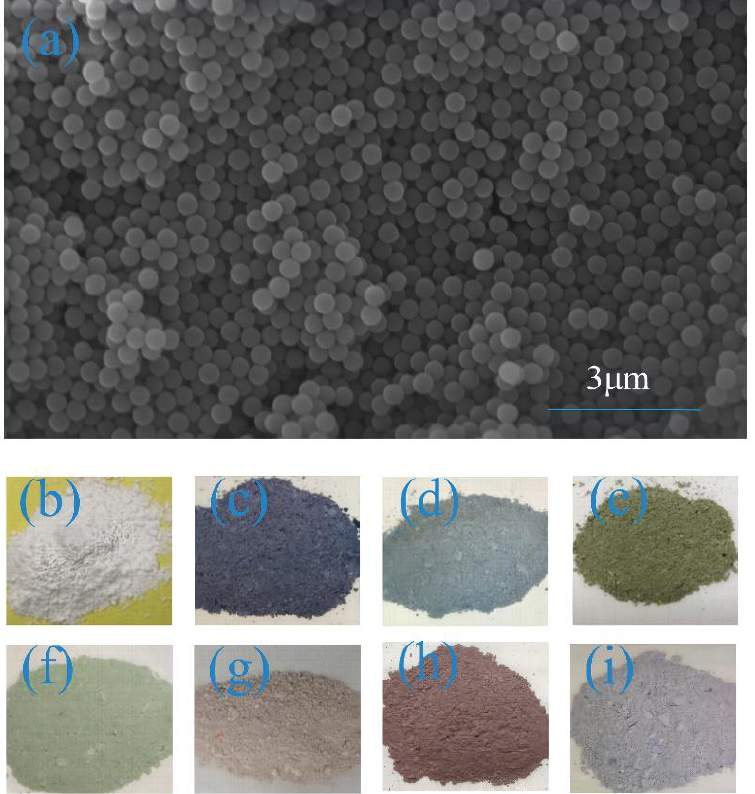
Figure 1. ( a ) SEM images of SiO 2 @PDA microspheres with diameters of 330 nm. ( b ) Picture of SiO 2 microsphere. ( c – i ) SiO2@PDA microsphere powders with different diameters are as follows: 198nm, 234 nm, 271 nm, 290 nm, 330 nm, 360 nm, and 394 nm. The XRD images of SiO 2 microspheres and SiO 2 @PDA microspheres are shown in